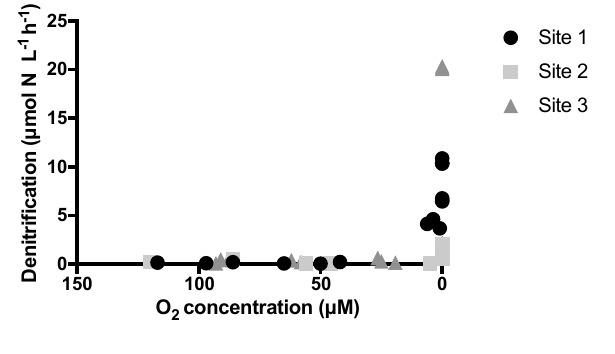
Figure 4. Denitrification rate as a function of oxygen concentration at the outlet of the columns at the three study